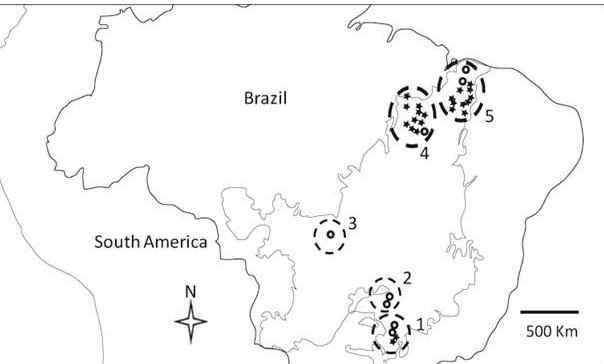
Fig 1 . Overview of survey locations. Stars: this study. Circles: Surveys from literature. Surveys: 1: São Paulo state surveys (EEI, IAB, Santa Teresa and USP Ribeirão); 2: Minas Gerais state surveys (Araguari and Panga); 3: Mato Grosso survey (Bacaba); 4 and 5: Maranhão state surveys, being 4: Arizona, Bacabinha, Balsas, Bom Walter, Feio, Formosa, Gleba Cajueiro, and São Francisco; 5: Arizona, Buriti, Carmo, Castiça, Cocalinho, Jatoba, Macaco, Normasa, São Lourenço, São Luizinho, Sipauba, Tabocal, Urbano Santos, and Urubu. The light delimited area corresponds to